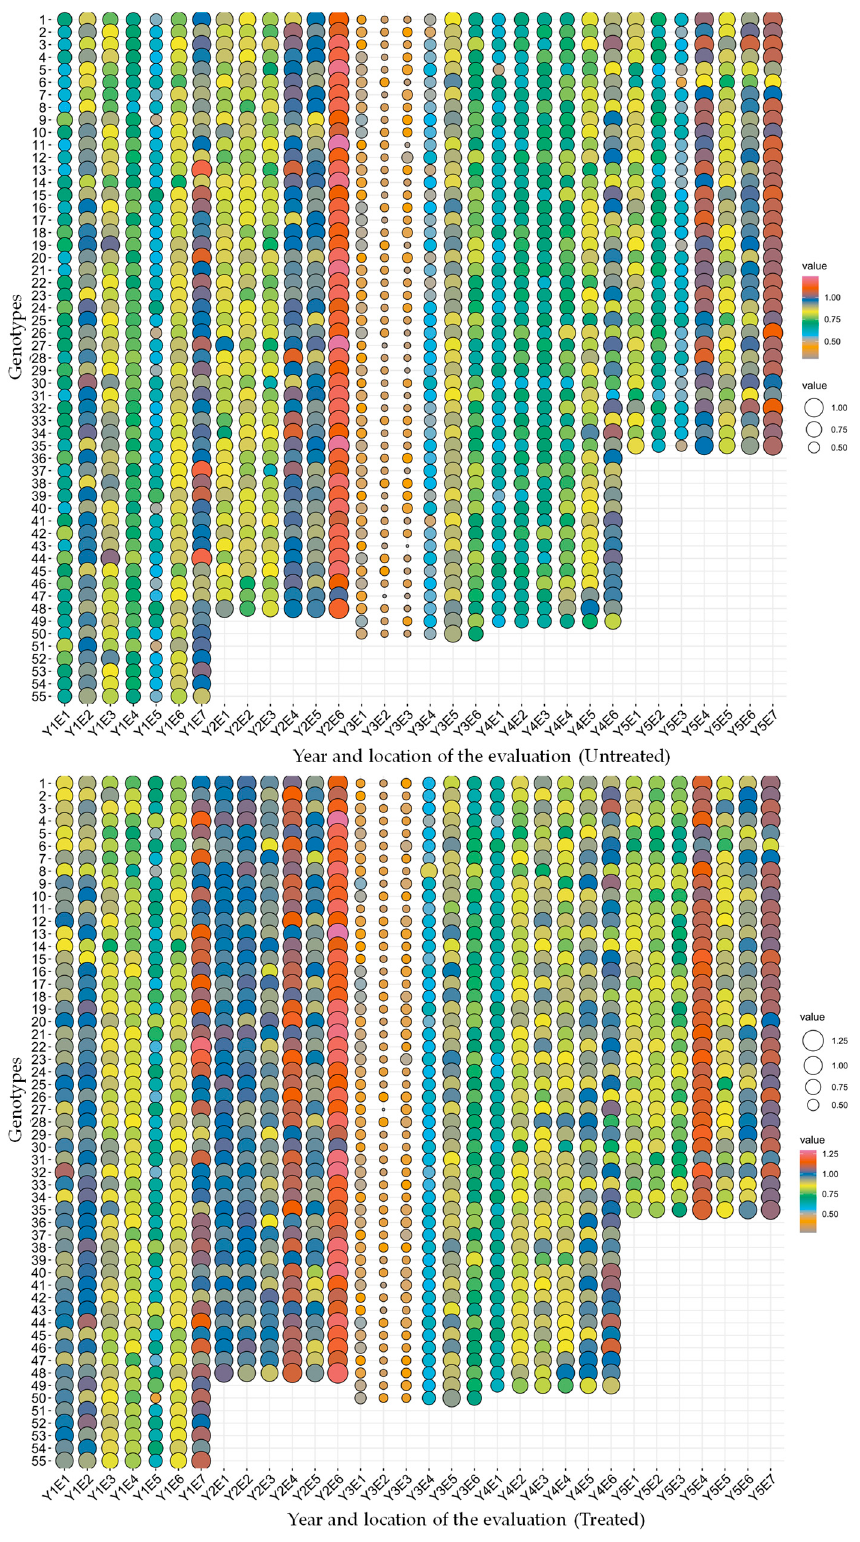
Figure 1. Balloon plot representing grain yield (kg m − 2 ) of tested genotypes under untreated and treated conditions. The legend of colour scale value and different size balloon scale value represent the grain yield (X axis represents year and evaluated environments. Y axis represents the genotypes